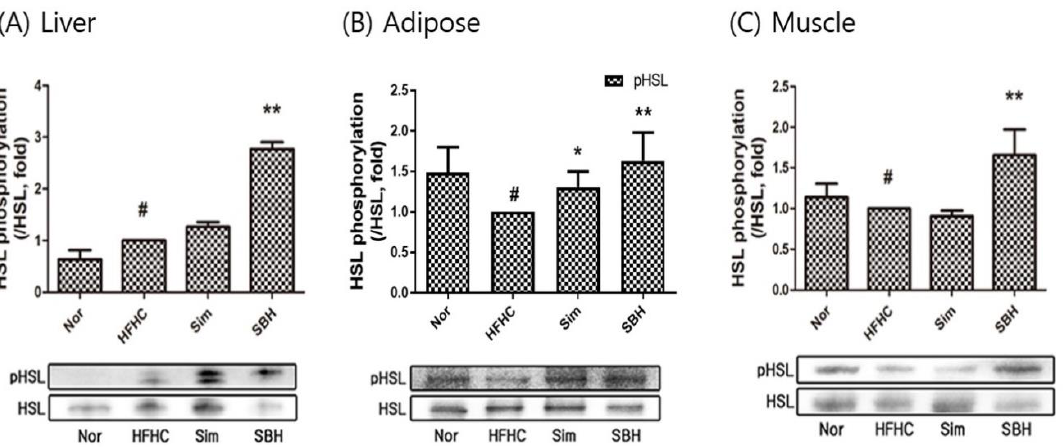
Figure 7. Expression of HSL phosphorylation in liver ( A ), adipose ( B ), and muscle ( C ) tissues. The number of experiments: Nor ( n = 3), HFHC ( n = 3), Sim ( n = 3), SBH ( n = 3). Data are expressed as the mean ± SEM. # p < 0.05 compared with Nor; * p < 0.05, ** p < 0.01 compared with HFHC. Nor, normal control group; HFHC, high-fat and high-cholesterol diet group; Sim, HFHC diet plus Sim group; SBH, HFHC diet plus SBH group.